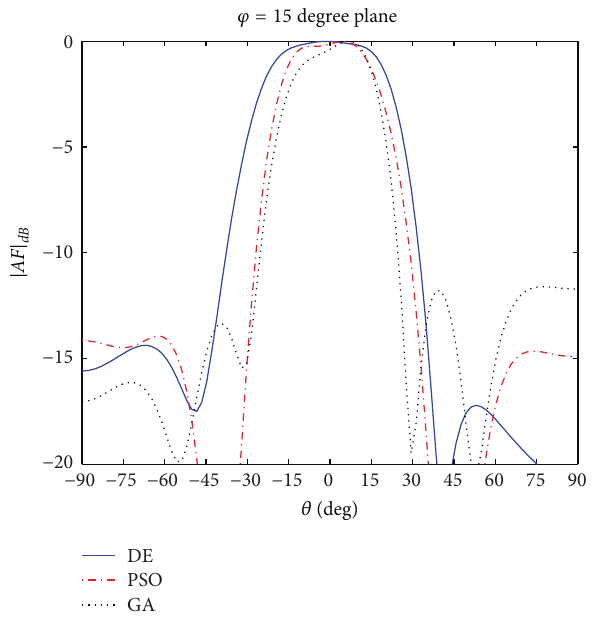
Figure5:Optimizedflat-toppatternsfromtheconcentricringarray for 𝜑 = 15 degree